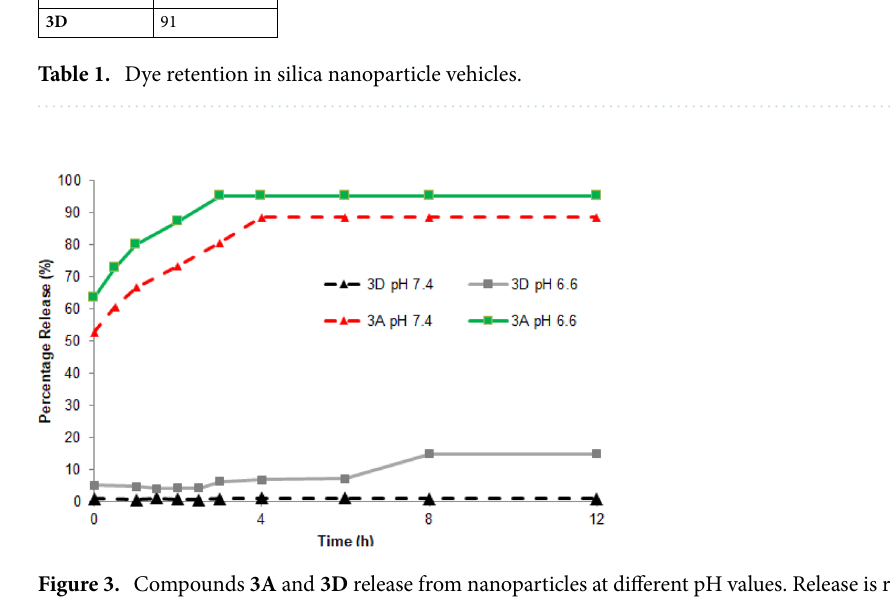
Figure 3. Compounds 3A and 3D release from nanoparticles at different pH values. Release is reported as a percentage (%) release compared to total fluorescence at the time of sample preparation prior to t = 0 h. Compound 3A loaded nanoparticles show high initial dye release of 53% and 63% for pH 7.4 and 6.6, respectively, at t = 0 h. Release of compound 3A increased (t = 0 h to t = 4 h) to and plateaued (t = 4 h to t = 12 h) at 89% and 95% for pH 7.4 and 6.6, respectively. Compound 3D loaded nanoparticles released far less dye overall from t = 0 h to t = 12 h. Compound 3D showed no release at pH 7.4, 0.9% at t = 0 h to 1.0% at t = 12 h,